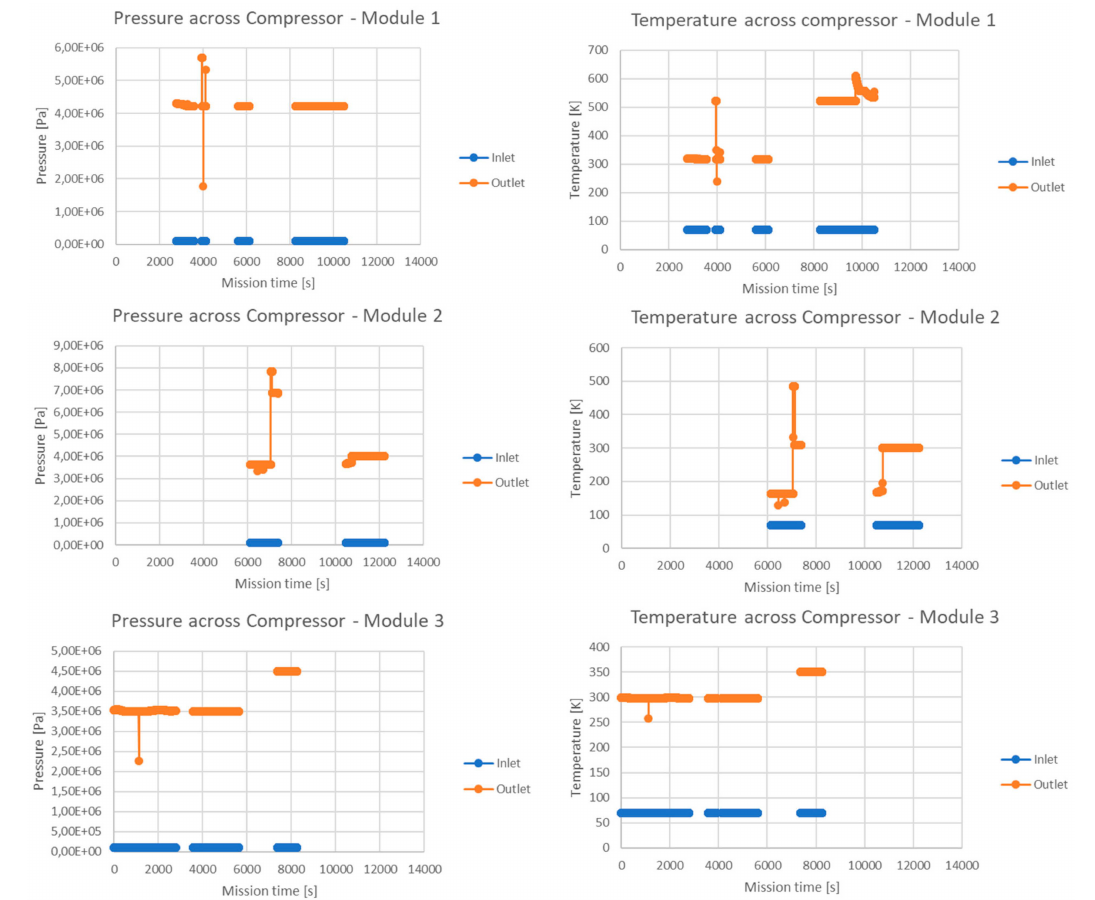
Figure 16. Pressure and temperature trends across boil-off compressors for the three TMS modules.